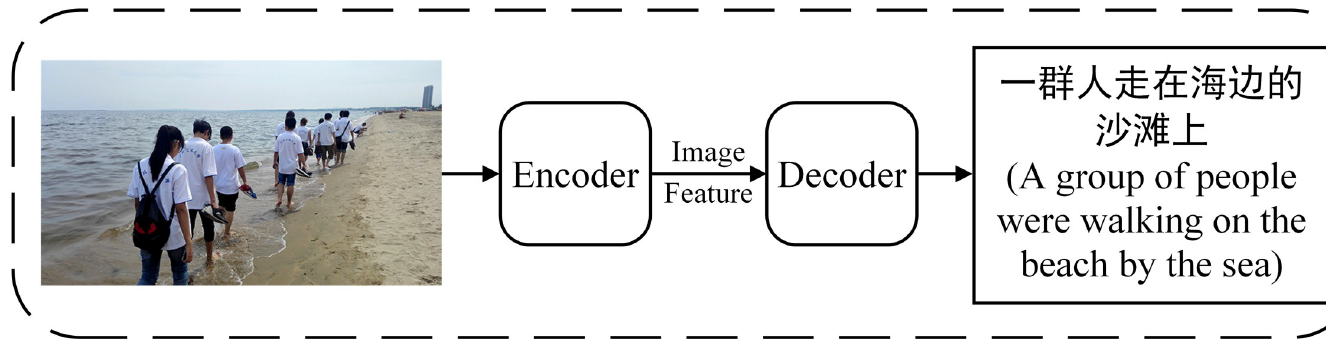
Fig 1. Encoding and decoding structure of Chinese description of image